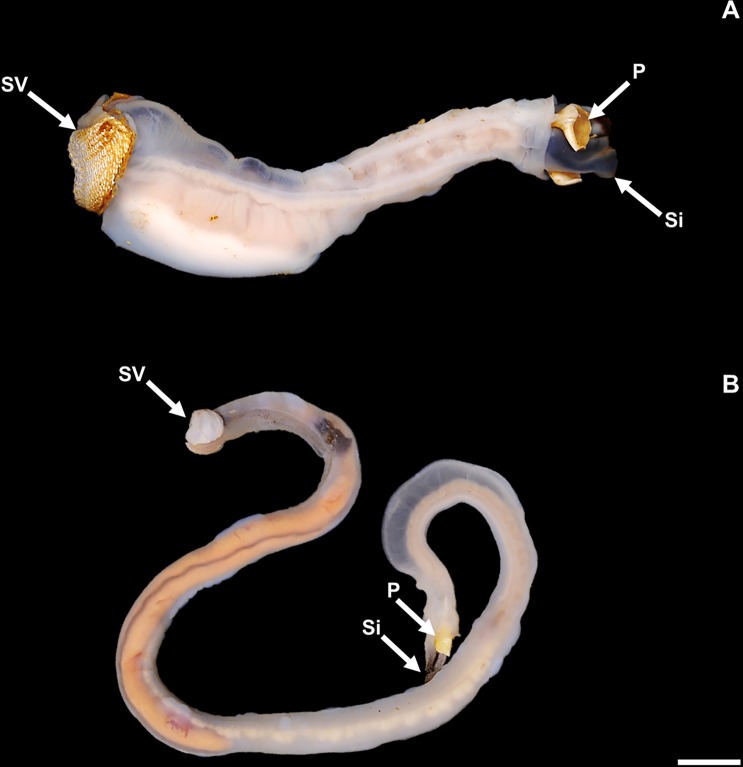
Shipworms from the Abatan River.(A) Specimen of stone-boring shipworm Lithoredo abatanica extracted from limestone. (B) Specimen of wood-boring-shipworm Nausitora sp. extracted from submerged wood clast. P = pallets; Si, siphons; SV, shell valves. Scale bar = 1 cm.